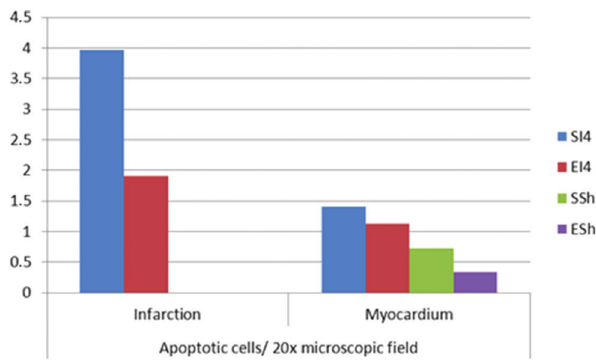
Figure 3 - Number of apoptotic cells per field in the infarcted and non-infarcted